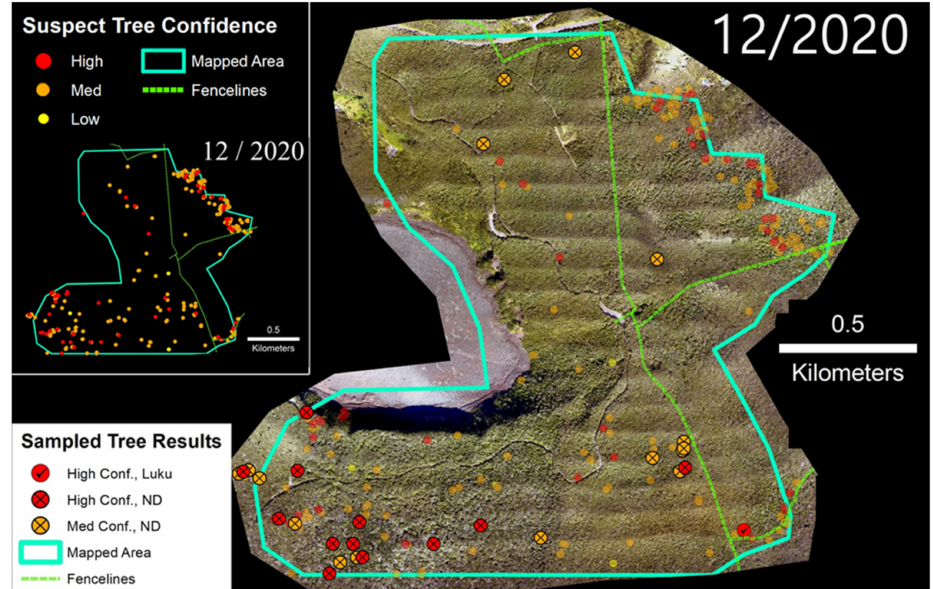
Figure 8. ( Left ) Suspect trees for the Thurston tract of Hawai‘i Volcanoes National Park. ( Right ) Sampled trees and corresponding laboratory results; non-sampled suspect trees appear as semi-transparent background points.